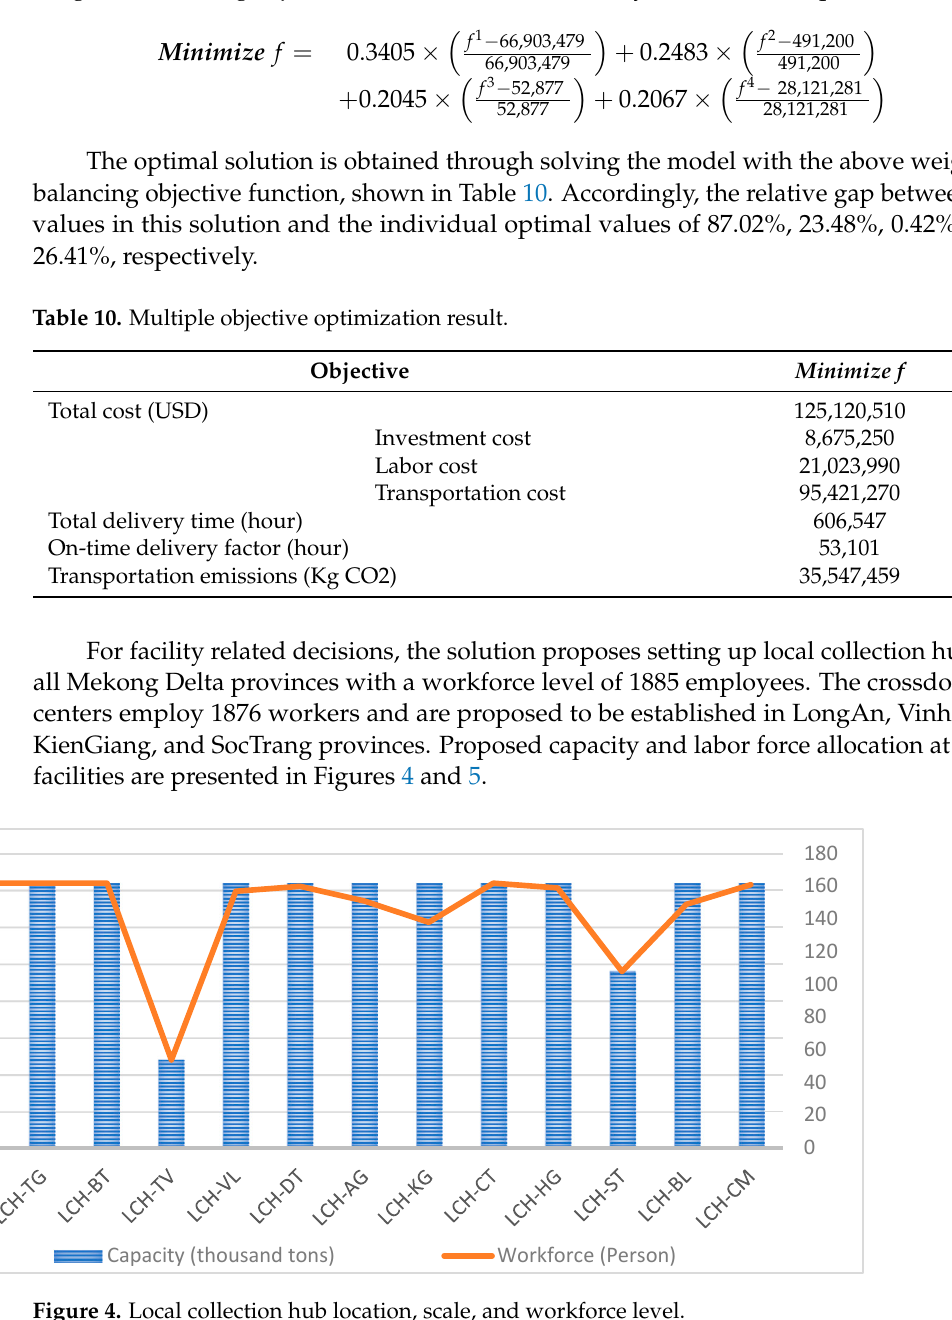
Figure 4. Local collection hub location, scale, and workforce level.